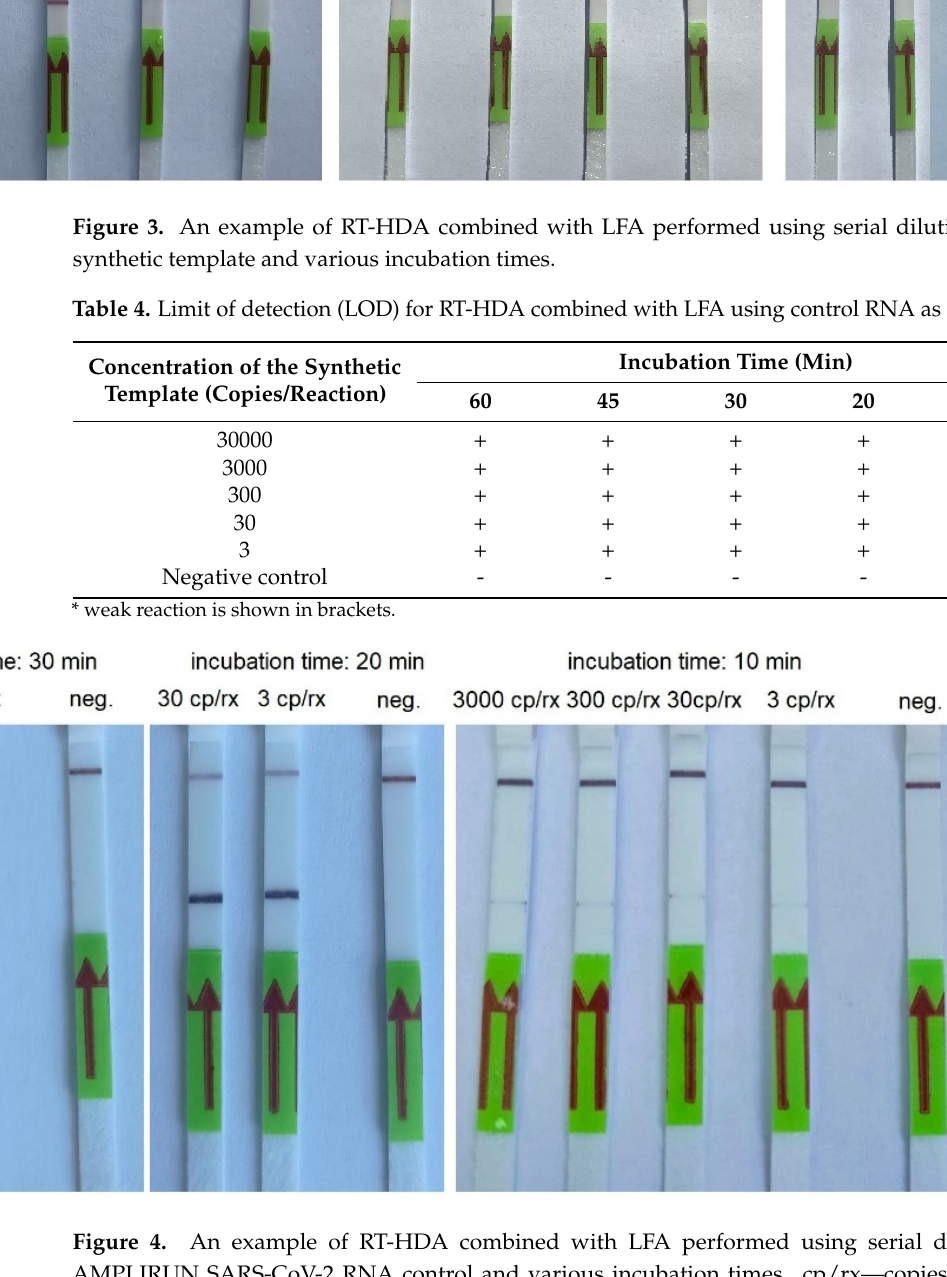
Figure 3. An example of RT ‐ HDA combined with LFA performed using serial dilutions of the syn ‐ thetic template and various incubation times. Table 4. Limit of detection (LOD) for RT ‐ HDA combined with LFA using control RNA as a template.